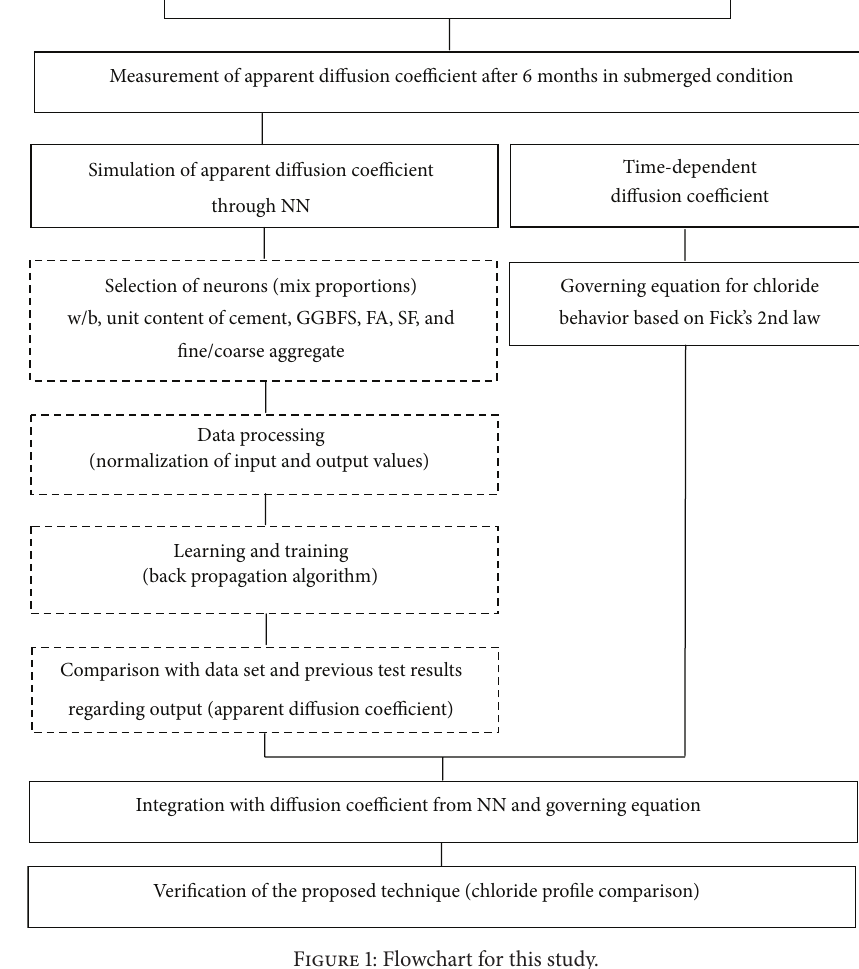
Figure 1: Flowchart for this